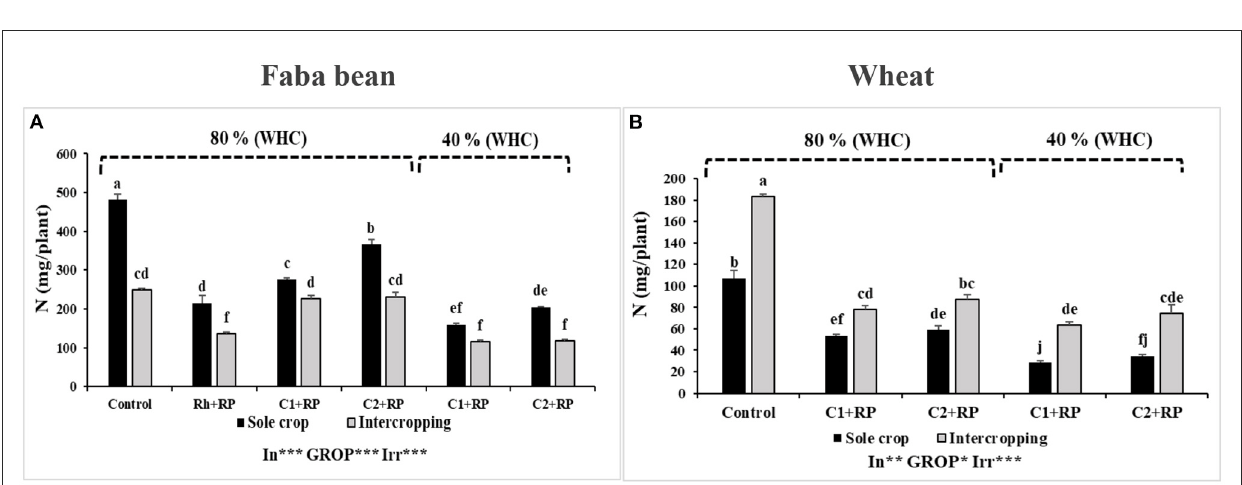
FIGURE8 Faba bean (A) and wheat (B) N contents. Plants were grown as a sole crop or intercropped under water sufficiency and P limitation (80% WHC, RP) vs. combined water deficit and P limitation (40% WHC, RP) and inoculated with two rhizobacterial consortia (C1 and C2) containing rhizobia and two PGPRs. The positive controls were supplemented with 125 µ mol/l of KH 2 PO 4 and 46 mg/l of KNO 3 (control). The negative controls received RP and were inoculated with the rhizobia only (Rh + RP). Each value represents the mean ± standard error (SE) of three replicates (In, inoculation; GROP, type of cropping; Irr, irrigation). Values with different letters are significantly different at 0.05 level of probability by Student-Newman-Keuls. * Represent the significance level of